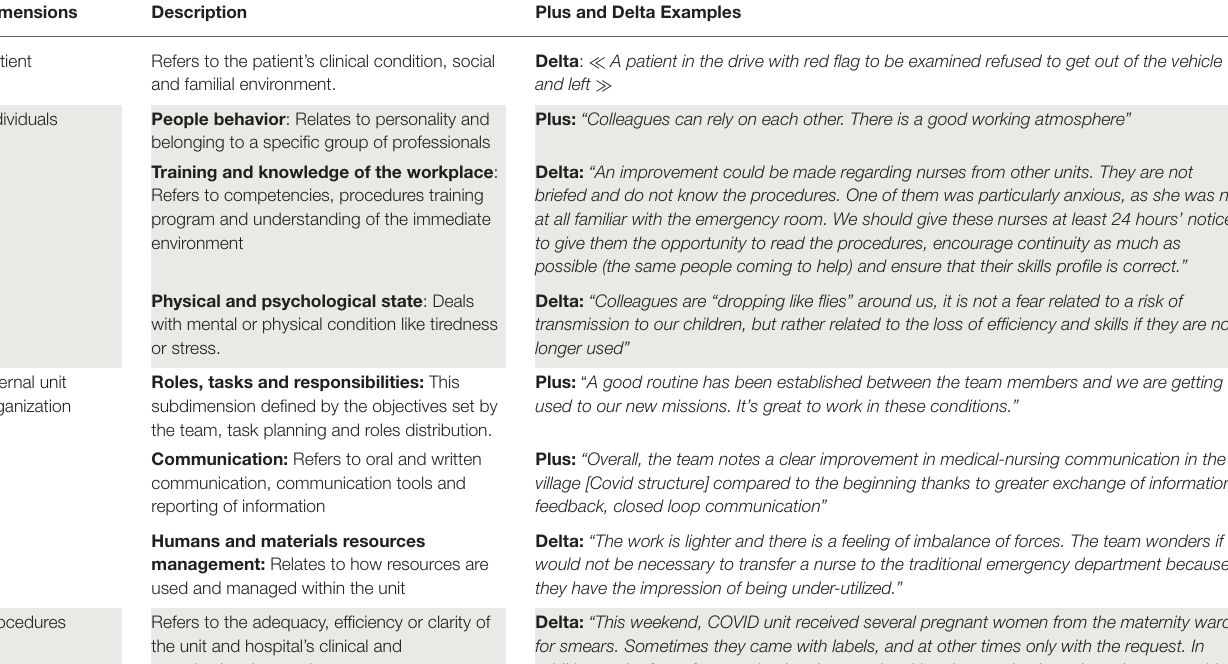
TABLE 4 | Debriefing and Organizational Lessons Learned (DOLL) framework dimensions and subdimensions examples. Dimensions Description Plus and Delta